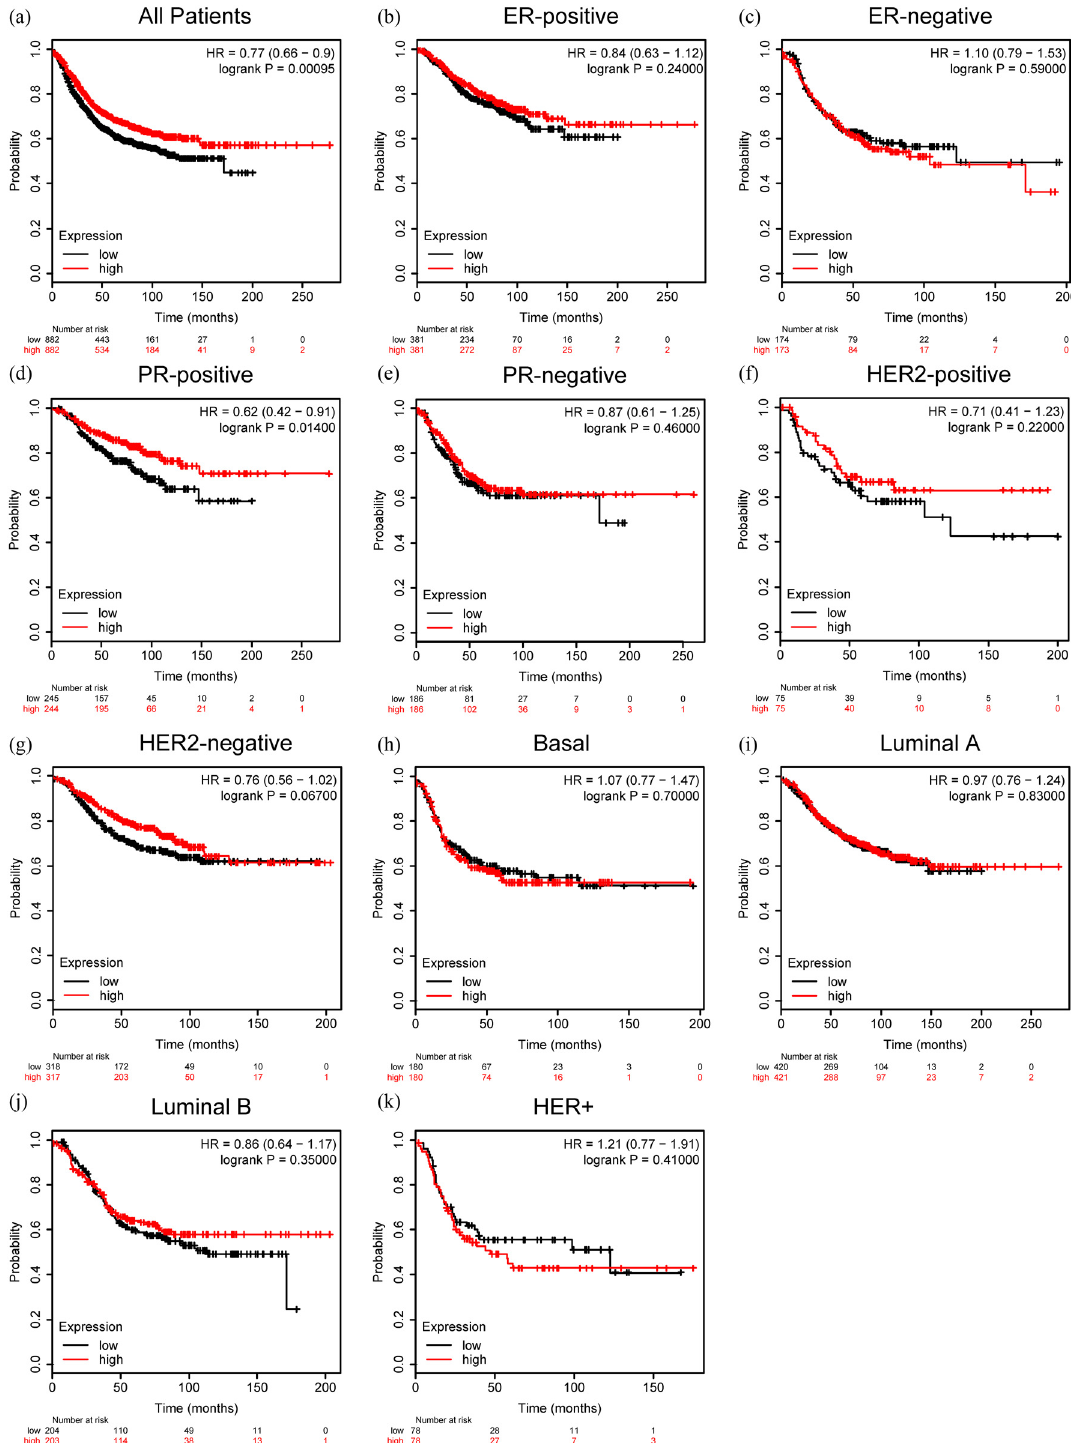
Figure 7: Prognostic value of ZG16B expression in di ff erent subtypes of breast cancer. The RFS curves were drawn by Kaplan – Meier plotter in all breast cancer patients ( a ) and di ff erent subtypes of breast cancer, ER - positive ( b ) , ER - negative ( c ) , PR - positive ( d ) , PR - negative ( e ) , HER2 - positive ( f ) , HER2 - negative ( g ) , Basal ( h ) , Luminal A ( i ) , Luminal ( j ) , and HER2 + ( k )